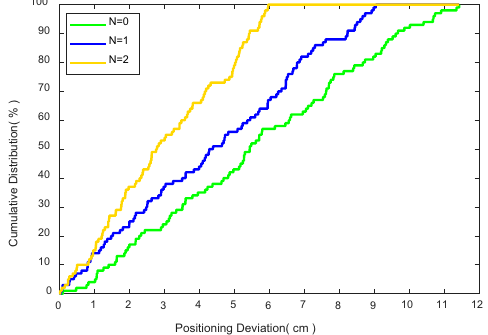
Fig. 4 . The positioning accuracy if the vehicle moves approximately in a straight